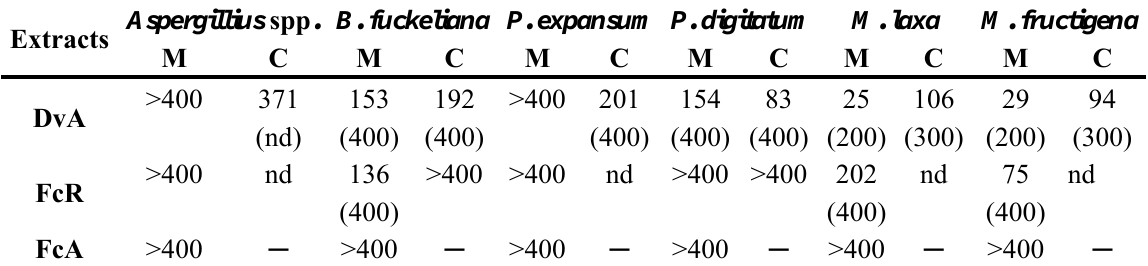
Table 6. ED (mg/L) and MIC (mg/L, between the brackets) of the extracts on colony 50 growth inhibitions after two ( B. fuckeliana ), six ( P. digitatum ), seven ( M. laxa and M. fructigena ), nine ( Aspergillus spp. and P. expa nsum) days and conidial germination inhibitions after 10-12 h of incubations. M: colony growth; C: conidial germination; nd: not determined due to lack of inhibition; ─ not